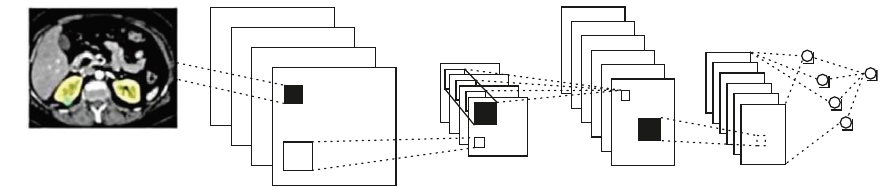
Figure 2: Basic deep convolution network structure.